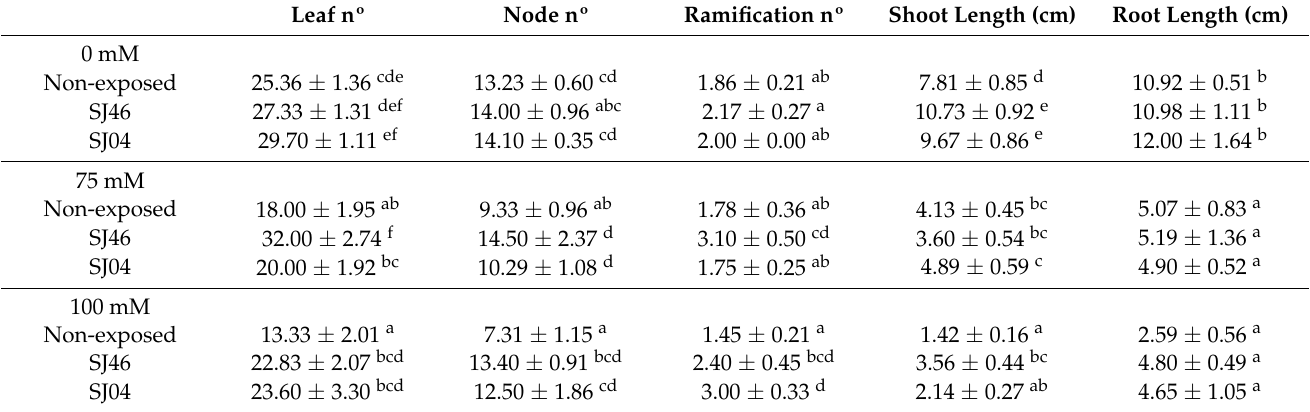
Table 1. The effect on M. piperita of mVOCs emitted by native P. putida SJ04 and SJ46 plant-growth- promoting bacteria for different growth parameters under salt stress conditions (0 mM, 75 mM and 100 mM). Means followed by the same letter within a column are not significantly different according to Fisher’s LSD test ( p <